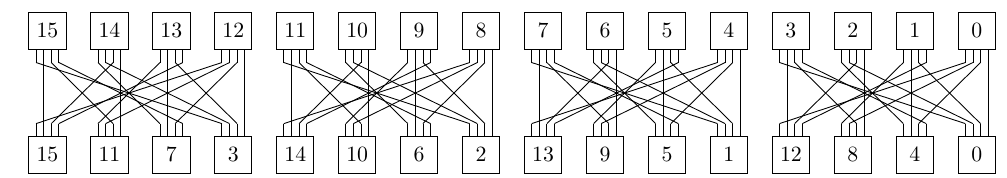
Figure 9: The bit permutation of GIFT-64 , with a rearrangement of the positions of the